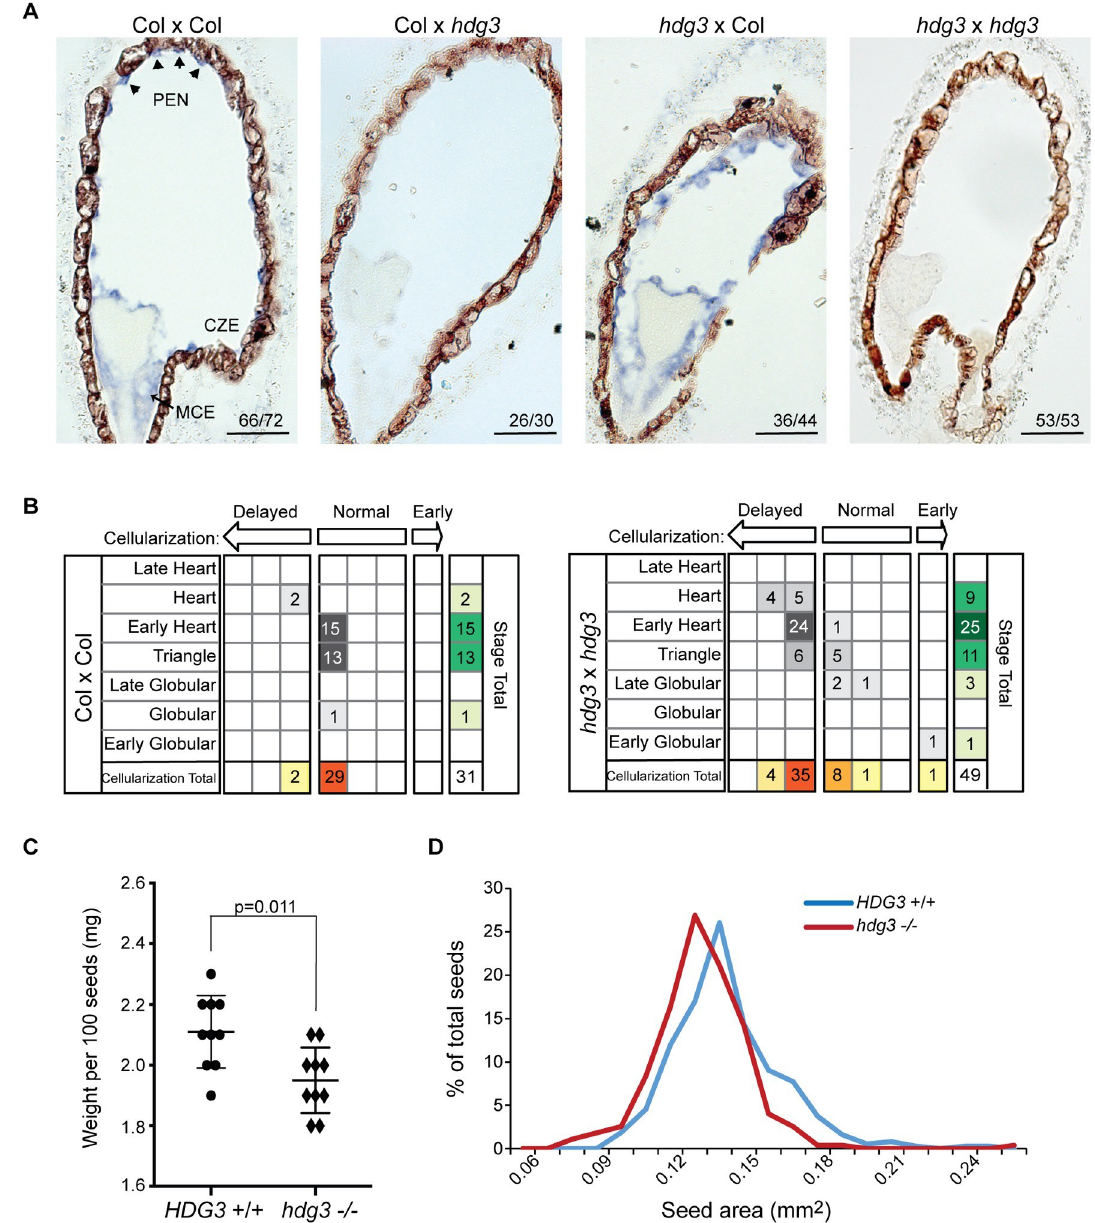
Fig 2. Phenotypic effects of mutation of HDG3 in Col. (A) In situ hybridization of HDG3 (purple) in seeds from the indicated crosses. Female parent is written first. Scale bars, 50 μ m. (B) Endosperm cellularization is slightly delayed in hdg3 compared to wild- type at 5 DAP. For each seed the embryo stage was determined and then the stage of endosperm cellularization was defined as normal, early, or delayed given that embryo stage. (C) Seed weight of wild-type and hdg3 seeds. Individual data points and mean +/- SD shown. P-value from unpaired two-tailed t-test. (D) Seed area is significantly reduced in hdg3 seed (n = 275) compared to wild-type siblings (n = 376) (p = 8.51e-11 by Welch’s two tailed t-test). Seeds were quantified with